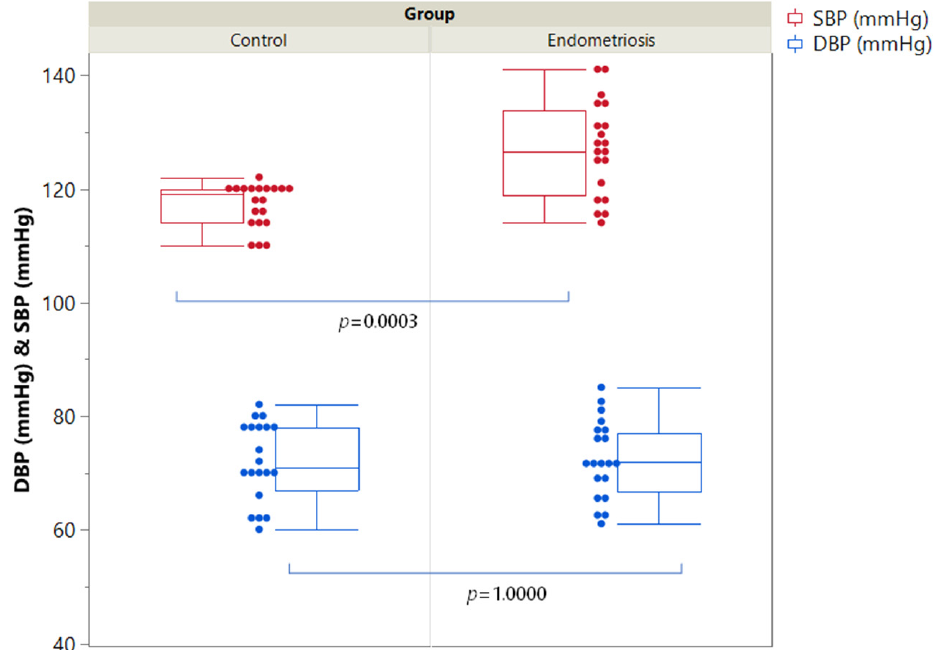
Figure 1. Distribution of Systolic (SBP) and Diastolic (DBP) blood pressure in the two groups of women. Single data points and box plots are presented. The edges of the boxes indicate the 25th and 75th quantiles, including the middle 50 percent of the data; the whiskers represent the range of data, calculated as (upper-quartile + 1.5 × IQR) and (lower quartile − 1.5 × IQR). Cortisol levels were normal in all women, but significantly lower in patients with endometriosis than controls (0.257 ± 0.051 vs. 0.399 ± 0.065 µ mol/L, p < 0.0001) (Figure 2). DHEAS levels and DHEAS to cortisol ratio were similar in the two